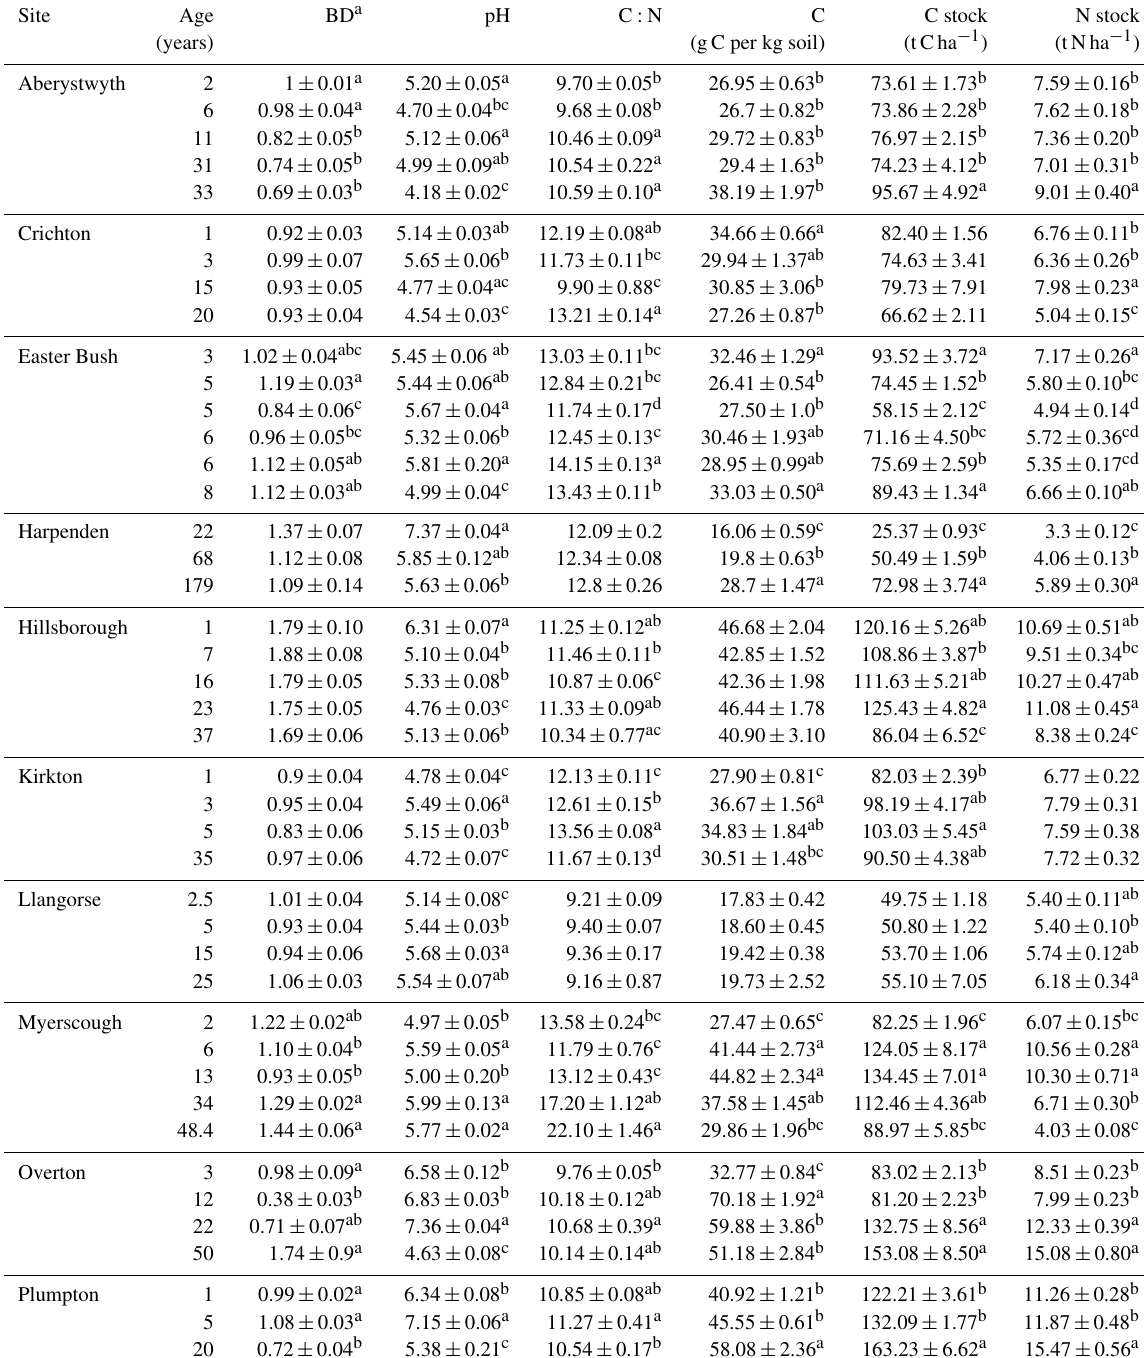
Table A1. Bulk-soil properties for each UK site. Values are means of 10 replicated in each field ± 1 standard error of the mean, except for Harpenden, where values are means of five replicates per field. Lettering indicates values that are significantly different, within a site ( p < 0 .